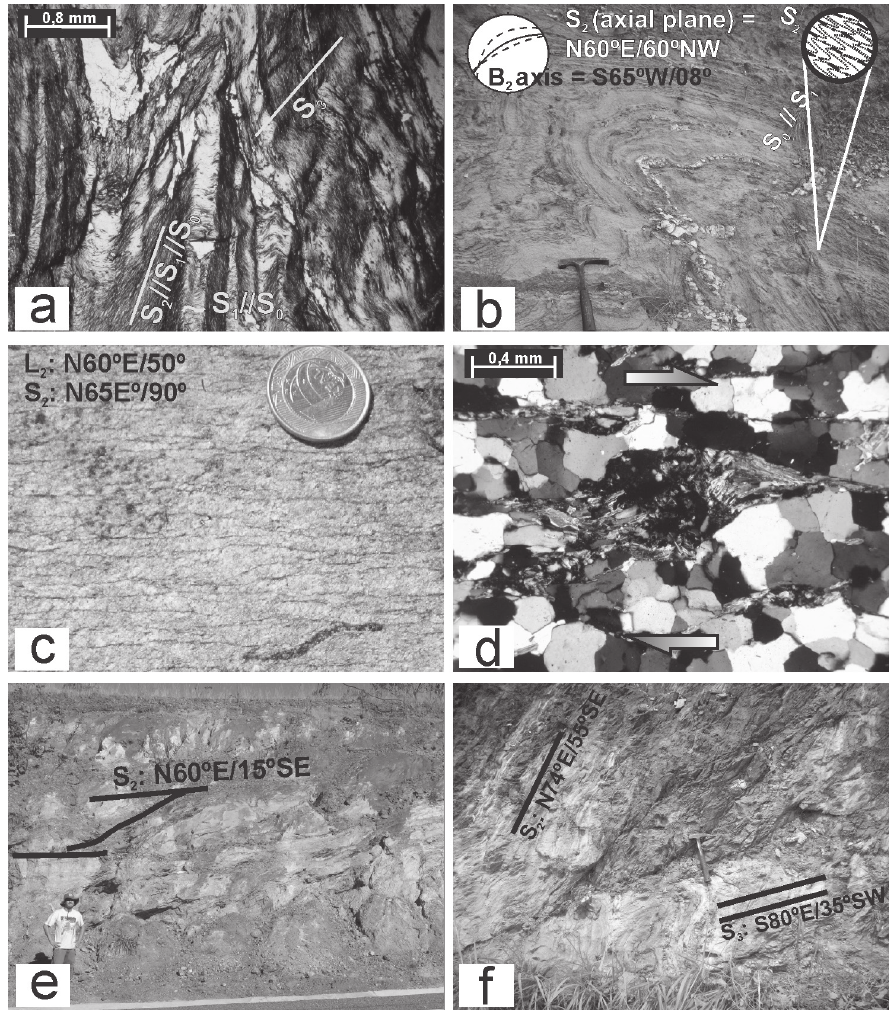
Figure 4 - Structural features of the Rio Preto fold belt. a) Photomicrography showing the microscopic relationships between the three deformational foliations, in fold hinge zones of a Canabravinha Formation phyllite, Southern Compartment; b) tight fold of the Canabravinha Formation, Southern Compartment; c) sub-vertical mylonitic quartzite of the Canabravinha Formation, Central Compartment, with development of S-C pairs; d) Photomicrography showing the microscopic aspect of mylonitic quartzite of the Central Compartment, with dextral shear sense indicator; e) ramp and platform geometry of thrust fronts in Formosa Formation schists, Northern Compartment; f) development of NW-verging thrust faults parallel to S crossed